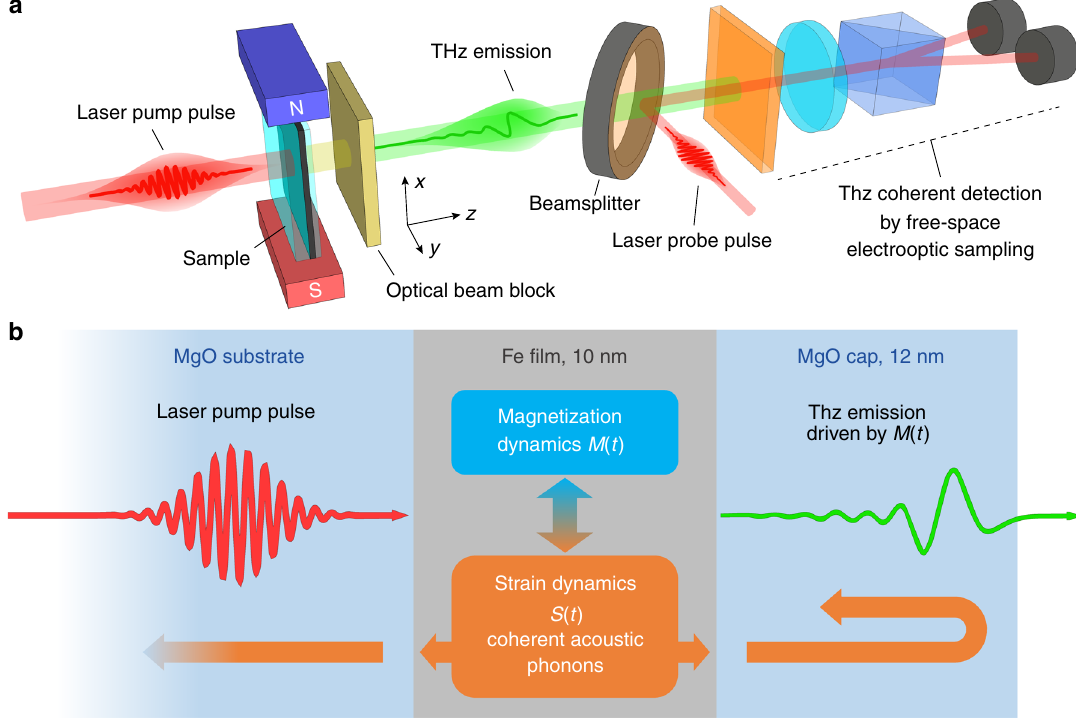
Fig. 1 Schematic of the experiment and the sample. a Sketch of the THz emission experiment: the sample is placed in the static in-plane magnetic fi eld of 63.4 mT, and excited with a 100 fs, 800 nm laser pulse at normal incidence. The THz emission from the sample in the forward-propagating direction is detected using free-space electro-optic sampling in a 1 mm ZnTe crystal, without any intermediate focusing or additional guiding. b Schematic of the sample: 10-nm-thick bcc Fe fi lm, grown on a 0.5-mm-thick MgO substrate, and capped with 12-nm-thick MgO cap. The excitation gradient of the electrons in the Fe fi lm in such a con fi guration is negligible, and hot-electron diffusion from the Fe fi lm is blocked by MgO substrate and cap. This eliminates the possibility of any ISHE-type mechanism, which relies on the motion of spin-polarized electrons in the sample, in the laser-induced magnetization dynamics M ( t ). The only possible contributions to M ( t ) in the sample remain hot-electron-driven transient demagnetization causing incoherent hot-magnon excitation (primary dynamics), and modulation of exchange interaction in Fe due to generated coherent acoustic phonons S ( t ) propagating in the structure (secondary